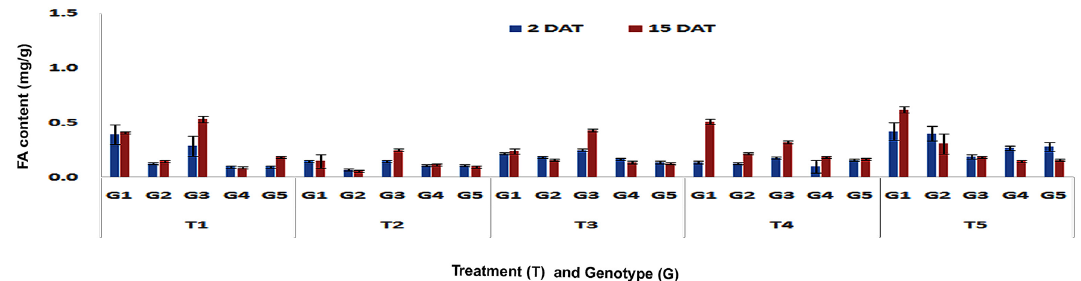
Figure 7. Changes in FA content in stalk tissues of maize genotypes to induced treatments in short (2 DAT) and long (15 DAT) term responses on the imposition of treatments at V3 stage (G1: DMRE 63; G2: CM 500; G3: WNZ Exoticpool; G4: CM 202; G5: BML 6; T 1 : Control; T 2 : PSB feeding; T 3 : Wounding; T 4 : Combination of wounding plus regurgitation; T 5 : Exposure to methyl